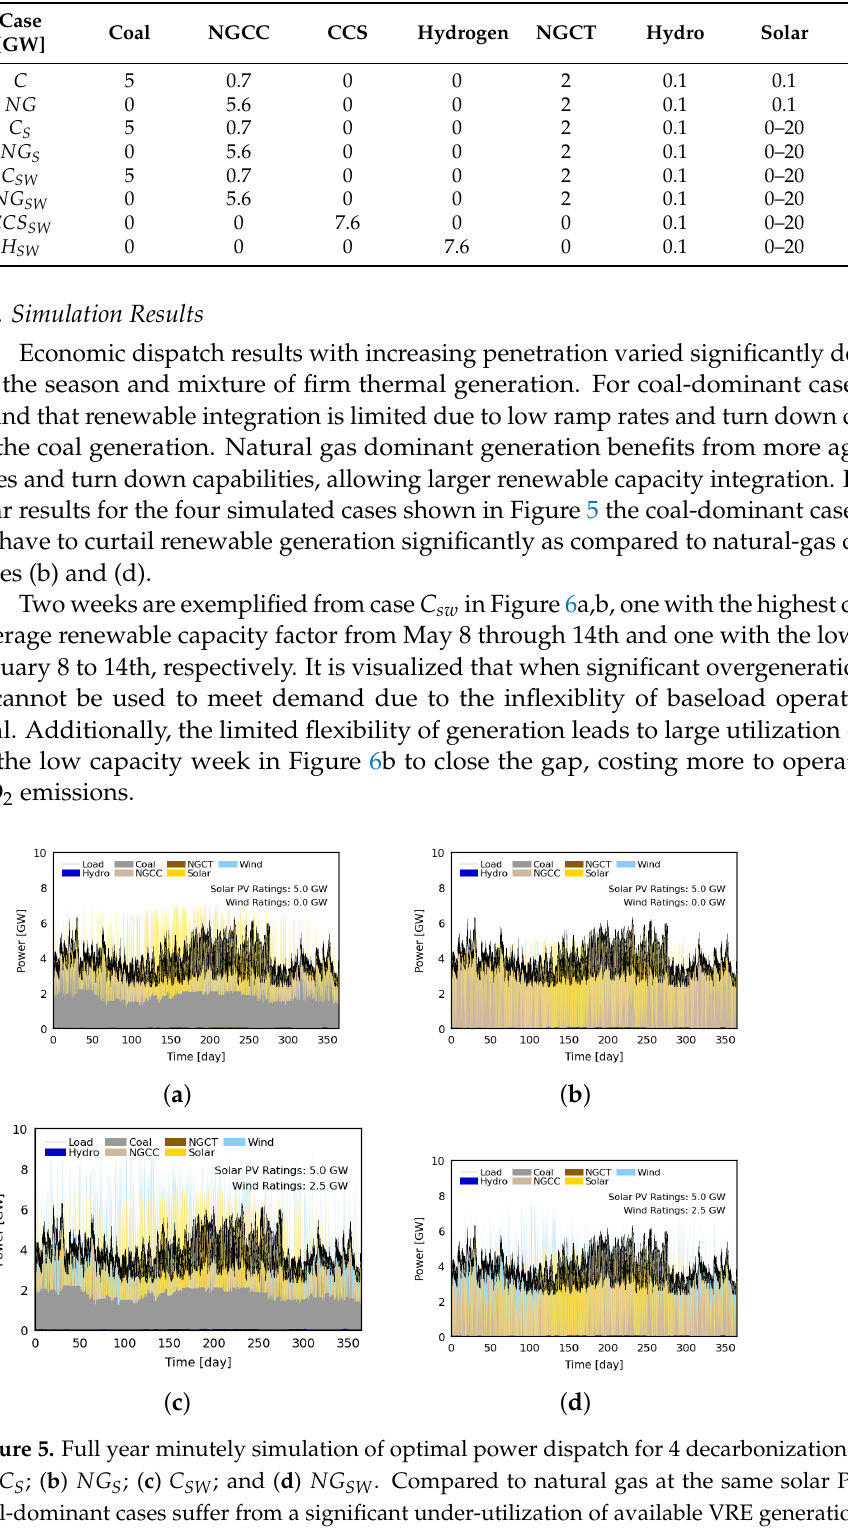
Table 2. Summary of generation portfolio capacity with thermal and renewable energy resources.